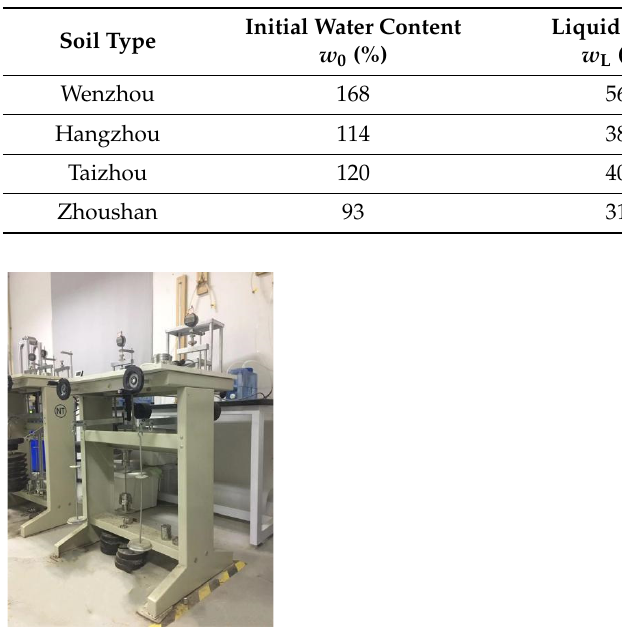
Table 2. Proportion scheme in the test.